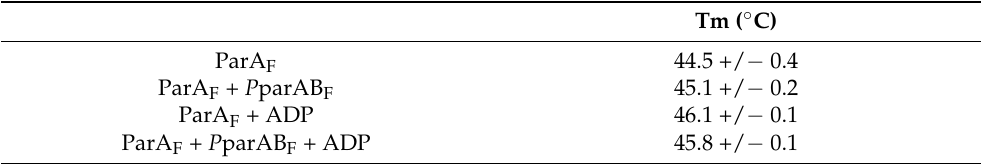
Table 1. Measurement of ParA F melting temperature. The melting temperature (Tm) of ParA F (3 µ M) was determined using a label-free fluorescence assay in presence or absence of ADP (1 mM) and/or 120-bp P parAB F DNA (250 nM). The standard deviation (+/ − ) was calculated from triplicate measurements. The data shown are from a typical experiment. Each assay has been reproduced three times with the same variations observed between each tested